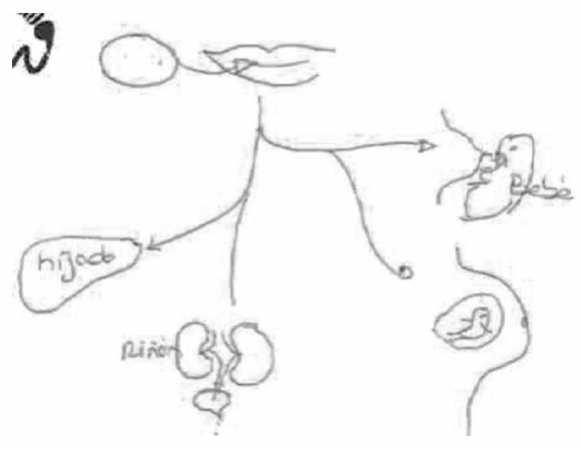
Figure 8. Breastfeeding, higher education, social worker.